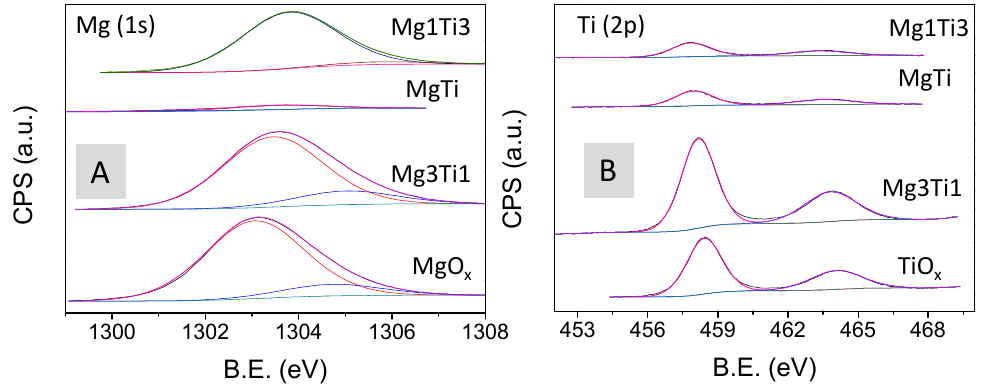
Figure 5. X-ray photoelectron spectroscopy (XPS) profiles of Mg(1s) ( A ) and Ti (2p) ( B ) in Mg–Ti solids.